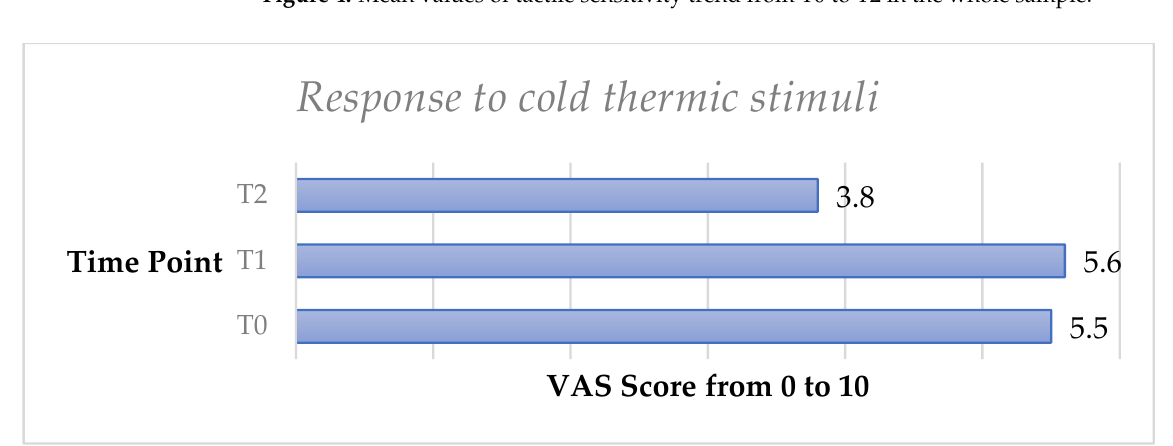
Figure 4. Mean values of tactile sensitivity trend from T0 to T2 in the whole sample.